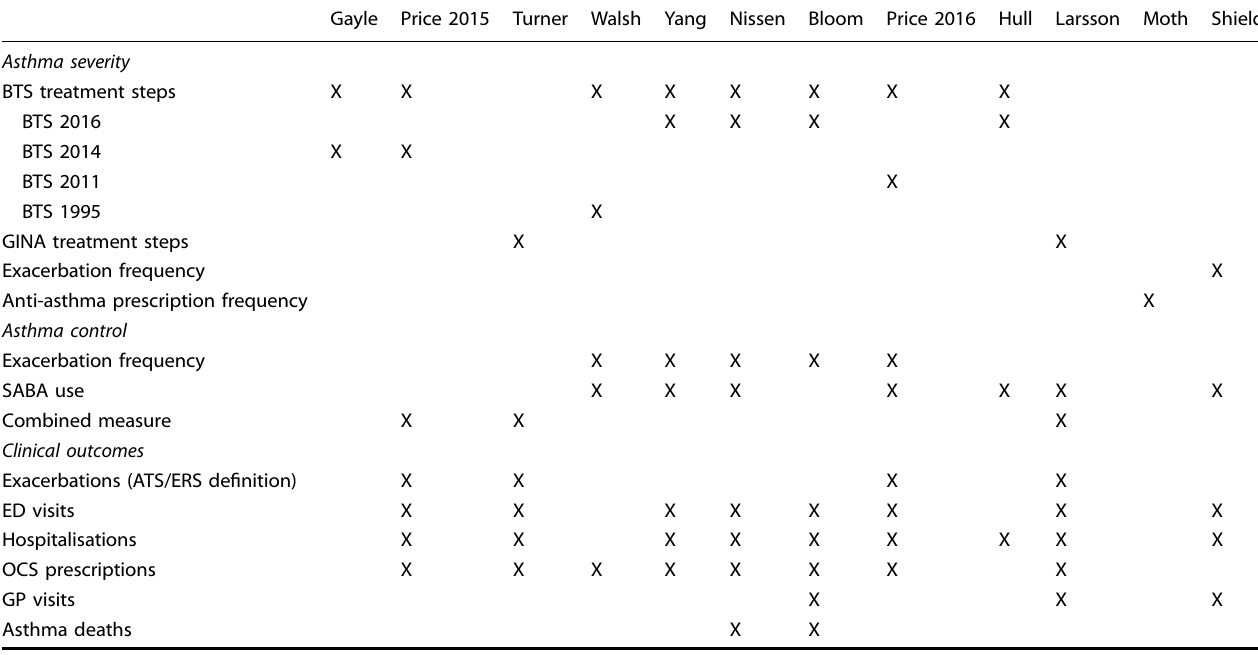
Table 3. De fi nitions of asthma severity, control and clinical